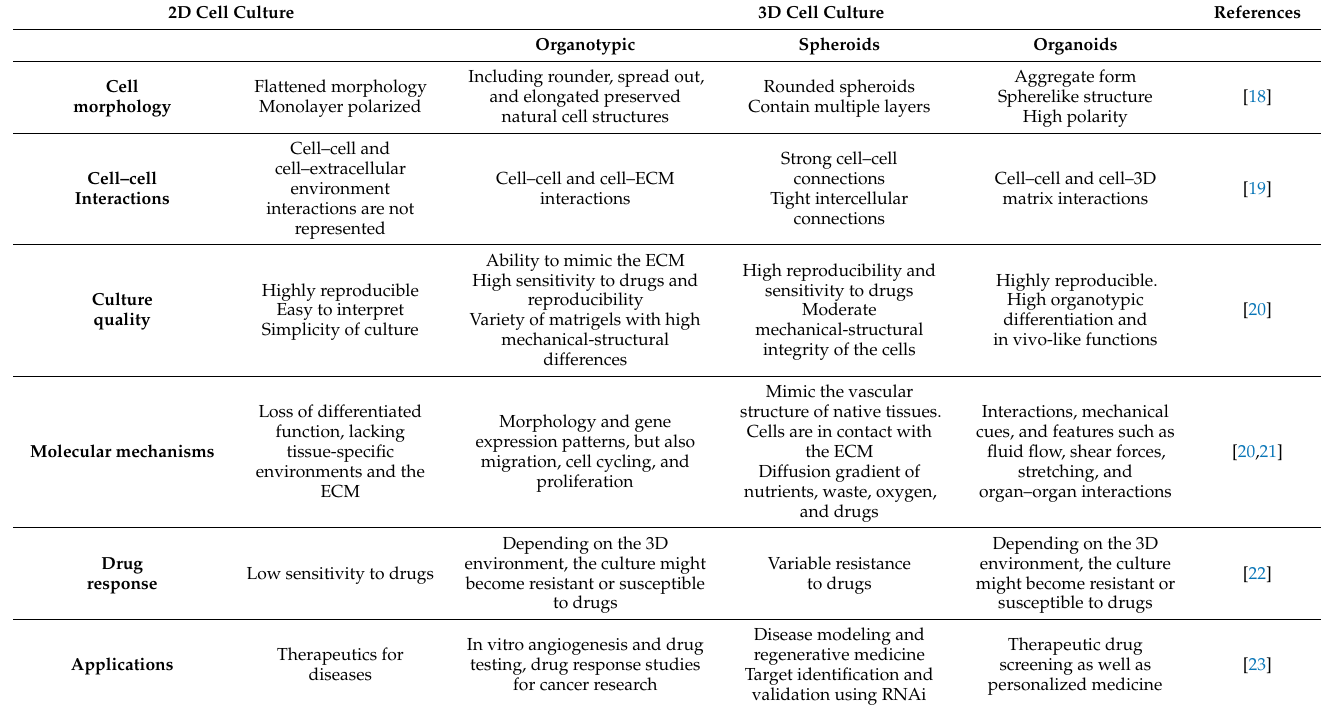
Table 1. Comparison of the different types of 3D and 2D cell culture